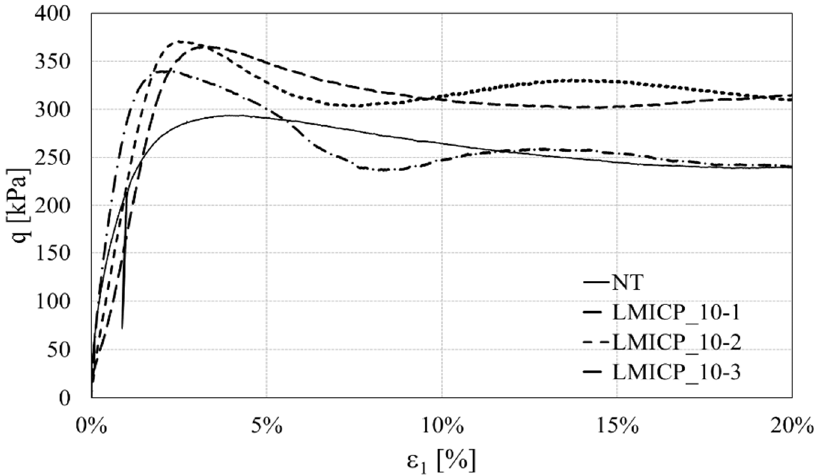
Figure 13. Triaxial compression at 50 kPa of total stress in Maicillo treated with LMICP.